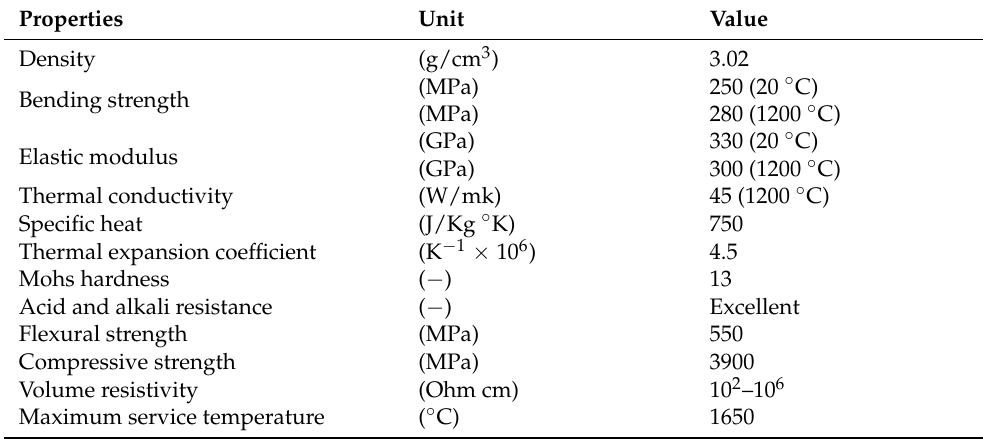
Table 9. Properties of silicon carbide fiber [142].